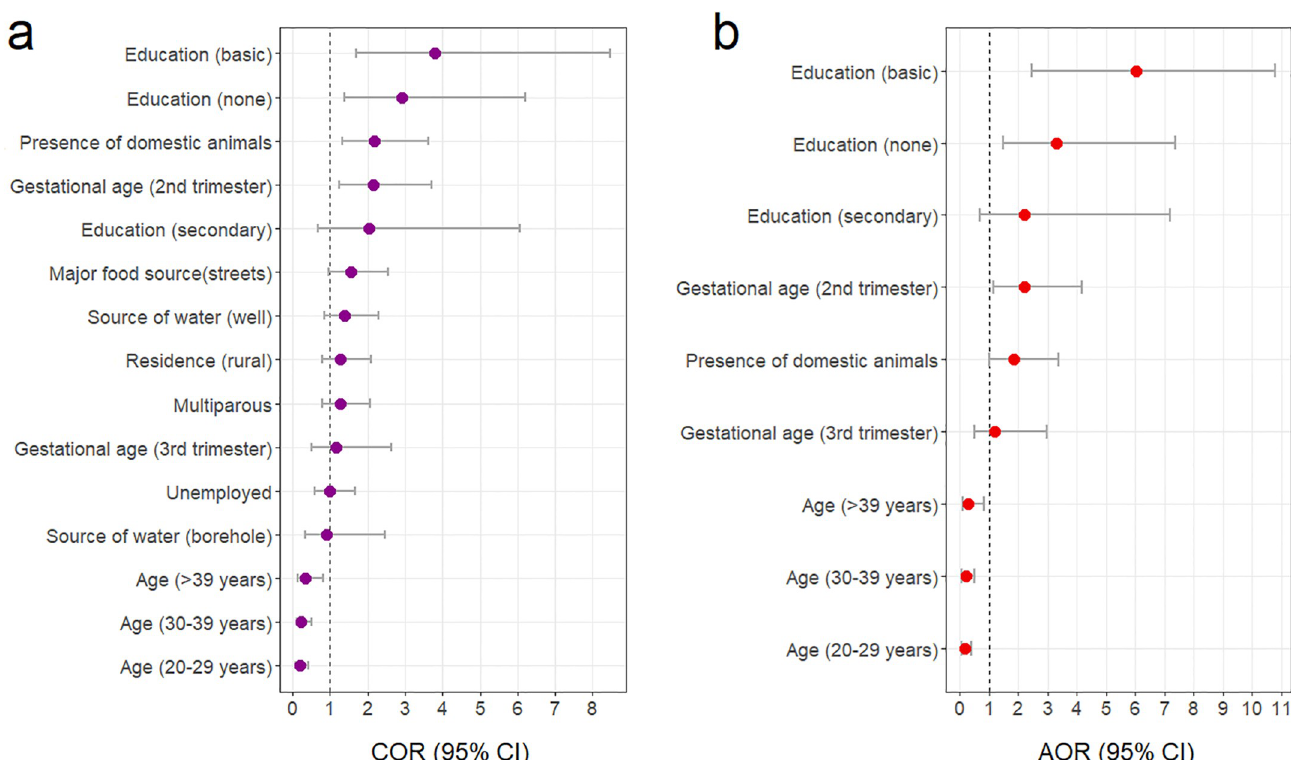
Fig 3. Crude and adjusted odds ratios for factors potentially associated with giardiasis. ( a ) Crude odds ratios; ( b ) adjusted odds ratios.